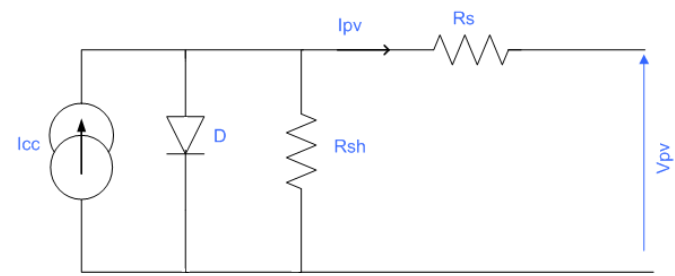
Figure 2. PV module real electrical